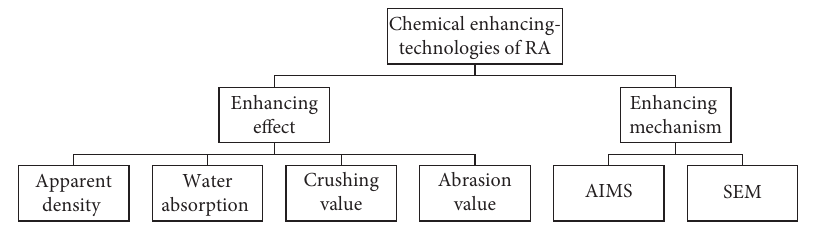
Figure 2: Technical route of this research. Table 1: Chemical enhancing materials and technologies.